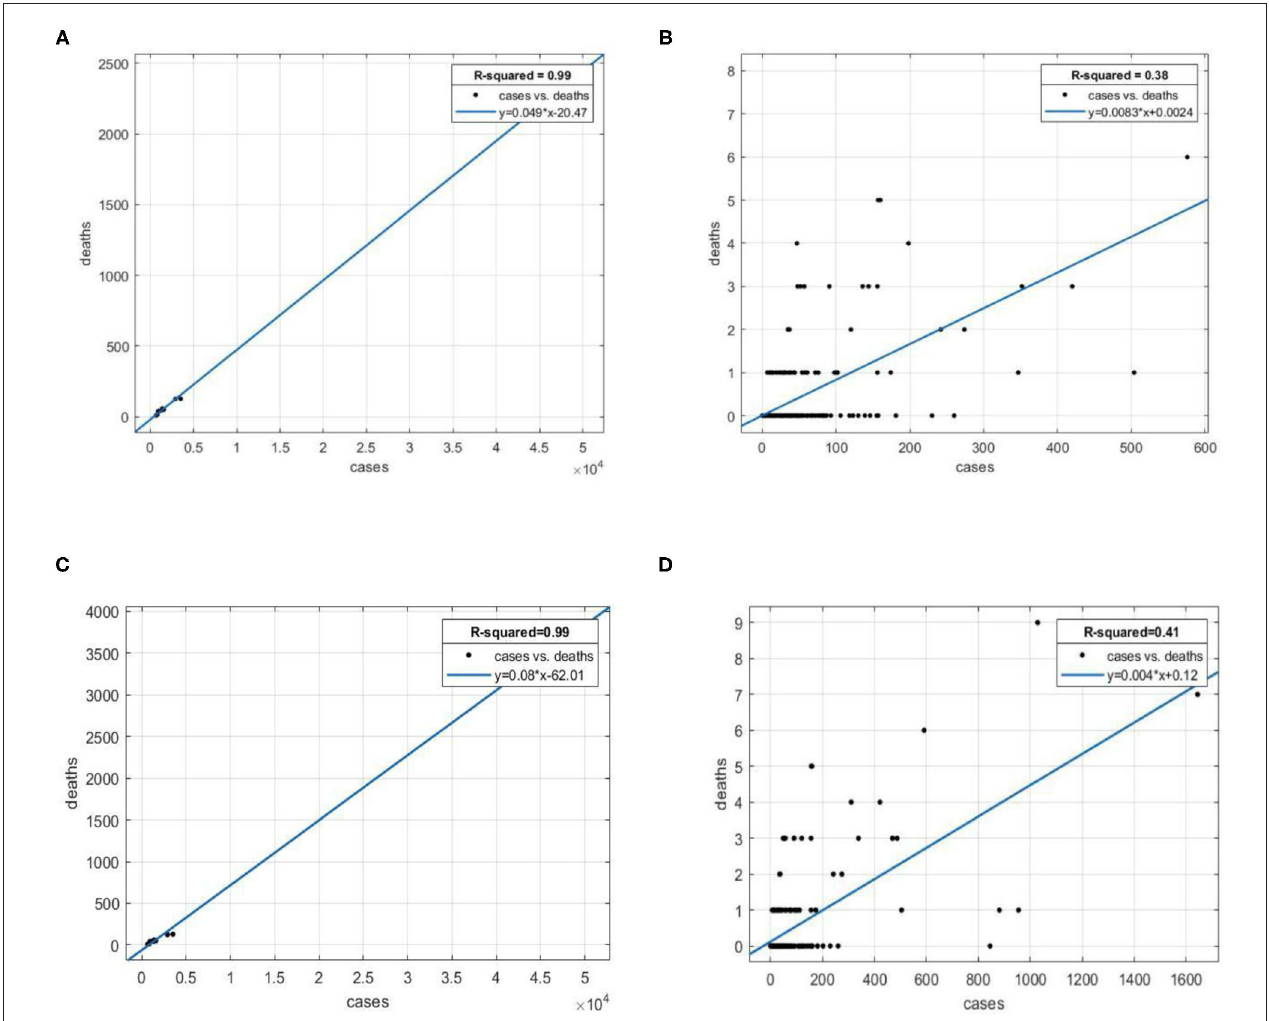
FIGURE 2 | Scatterplot of COVID-19 deaths against cases. (A) Hubei Province, March 13, 2020. (B) Outside Hubei Province, March 13, 2020. (C) Hubei Province, January 25, 2021. (D) Outside Hubei Province, January 25, 2021.